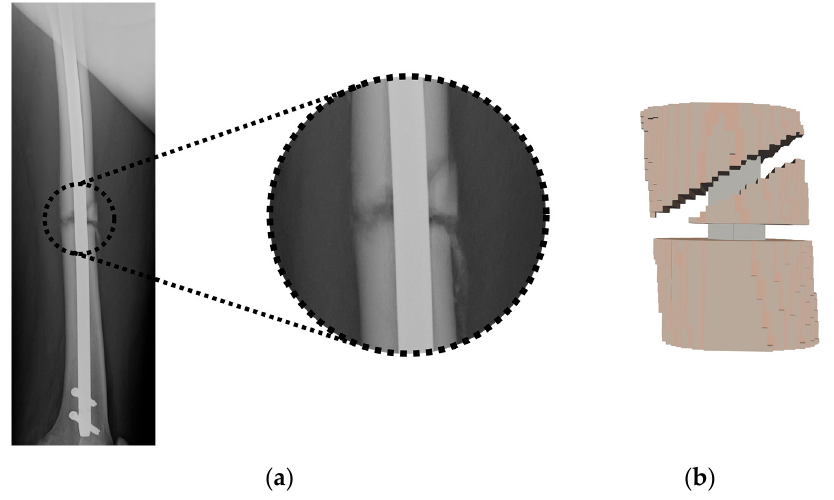
Figure 2. Selected region from the femur fracture: ( a ) radiological image; ( b ) voxel model.